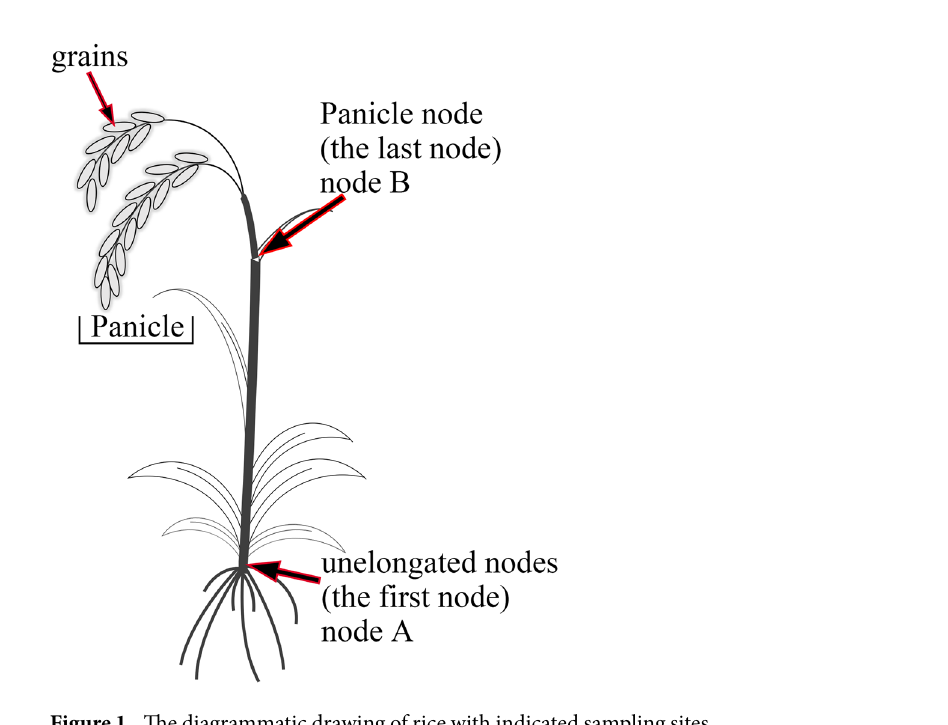
Figure 1. The diagrammatic drawing of rice with indicated sampling